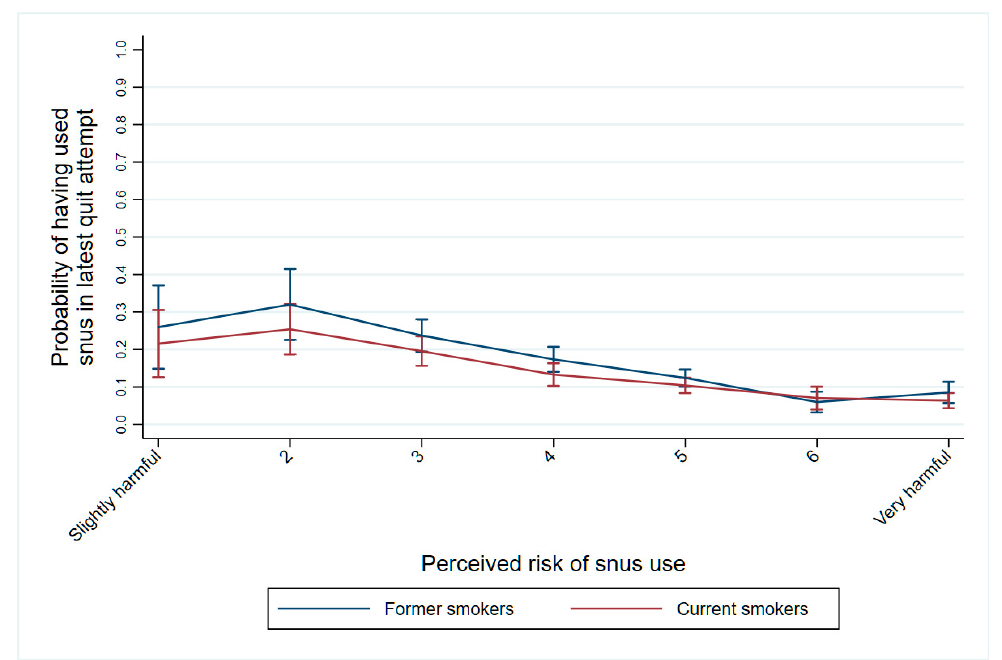
Figure 3. Adjusted predicted probabilities of having used snus in the latest attempt to quit smoking at different levels of perceived risk of, among current smokers ( n = 381) and former smokers ( n = 310).